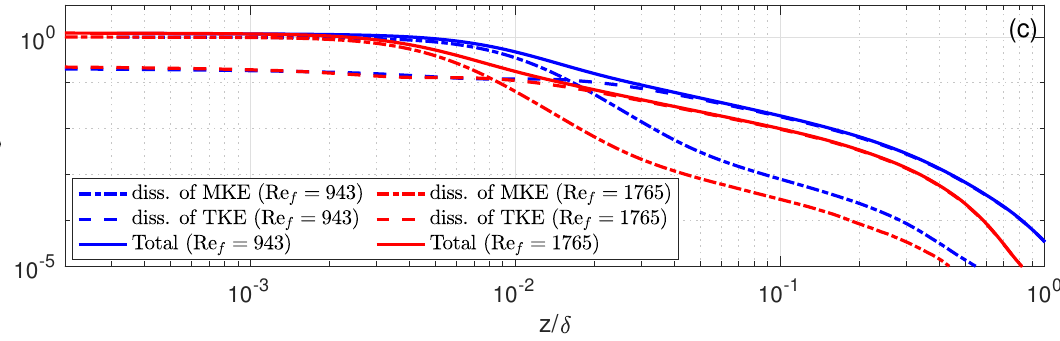
Figure 3. Profiles of non-dimensional velocity ( a ), shear stress including both viscous stress du + /dz + and Reynolds stress < u (cid:48) w (cid:48) > + ( b ) and dissipation rate ( c ) as a function of z / δ (depth normalized by the boundary layer thickness) in the DNS of rotating BBL.